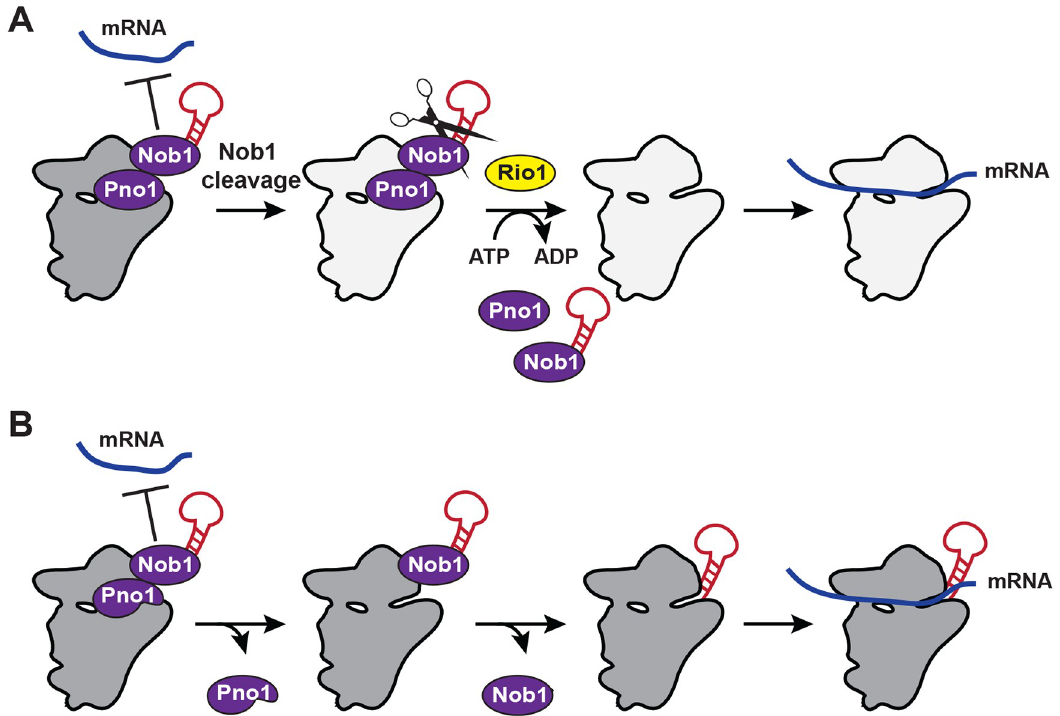
Fig 6. Model of Rio1’s role in 40S ribosome biogenesis. (A) Nob1 blocks mRNA recruitment. Following Nob1-mediated cleavage of 20S pre-rRNA to form the mature 18S rRNA, Rio1 binds the 40S-bound Nob1–Pno1 complex and releases both assembly factors from the nascent ribosome in an ATPase-dependent manner. This allows for Rps26 incorporation and mRNA recruitment. Therefore, Rio1 regulates the final stages of 40S maturation in the cytoplasm to only release fully mature ribosomes into the translating pool. (B) When Rio1 is bypassed, such as in cells expressing the weak-binding Pno1-KKKF, Pno1 can dissociate Rio1 independently, even before Nob1-dependent rRNA cleavage. Because Pno1 is required for D-site cleavage [18], this reduces the endonuclease activity of Nob1. Eventually Nob1 can be released, even when RNA cleavage has not occurred, allowing mRNA recruitment by immature 20S pre-rRNA-containing 40S